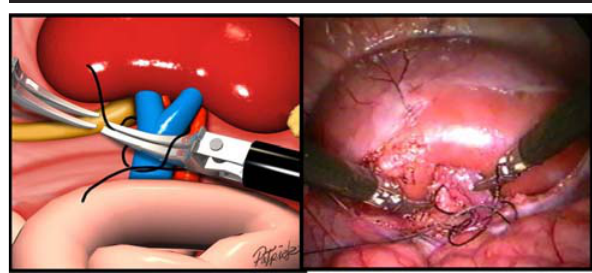
FIGURE 4 - The right hand grasper goes below the second loop and it catches the suture held by the left hand.